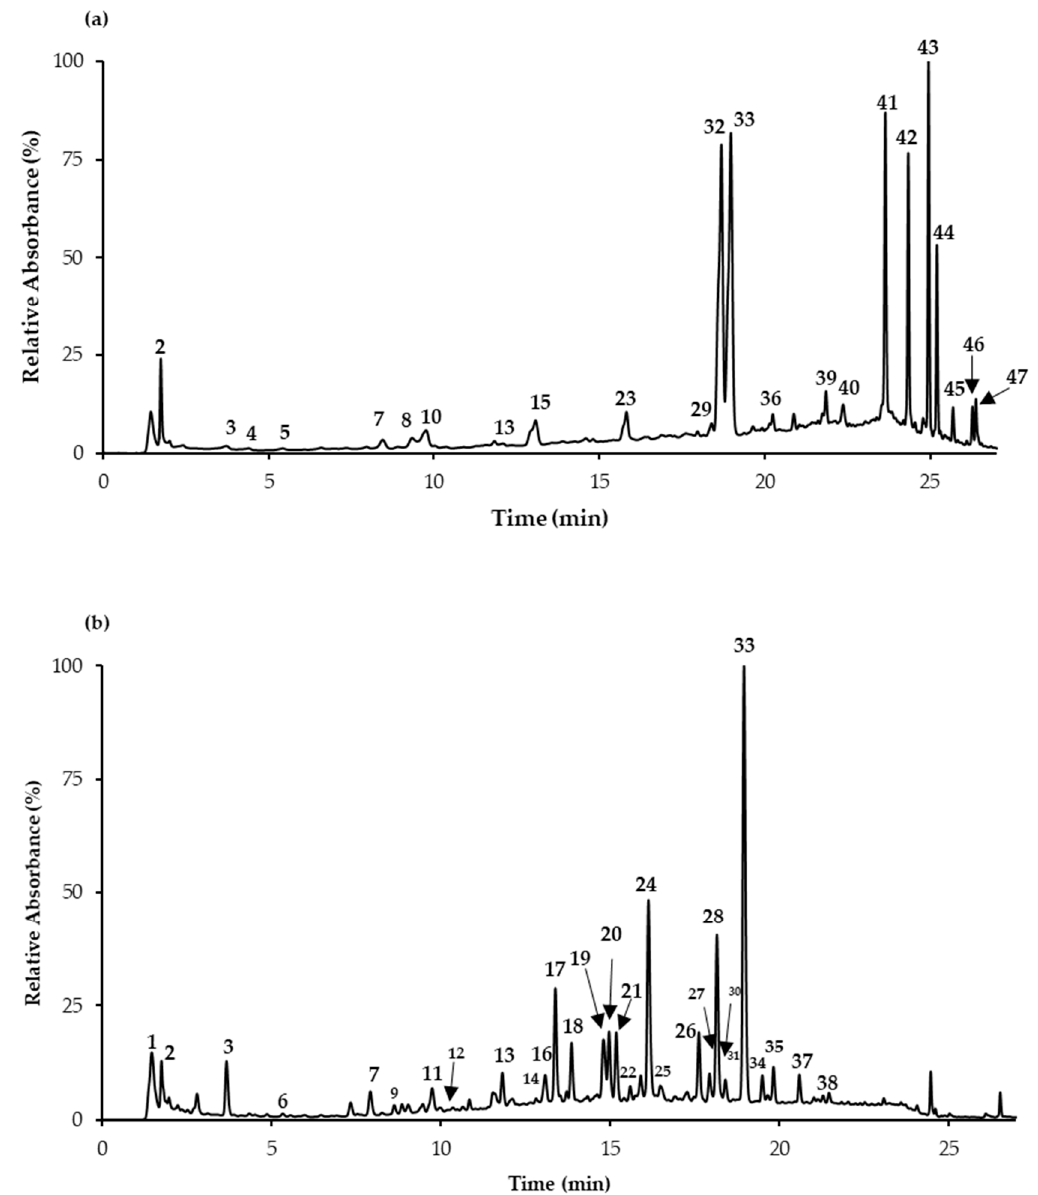
Figure 1. Chromatographic representation of Salvia decoctions at 280 nm: ( a ) S. apiana ; ( b ) S. farinacea var. Victoria Blue . Numbers in the figure correspond to the UHPLC-DAD-ESI-MS n peaks described in